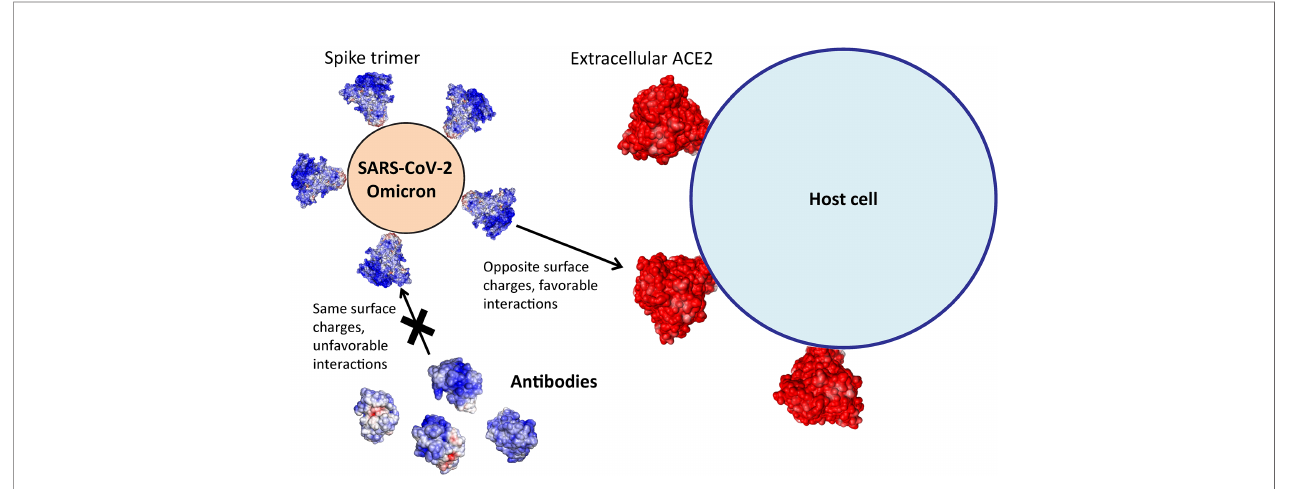
FIGURE 7 | Omicron Spike ’ s electrostatic potential surface evades most antibodies and promotes ACE2 association for host cell